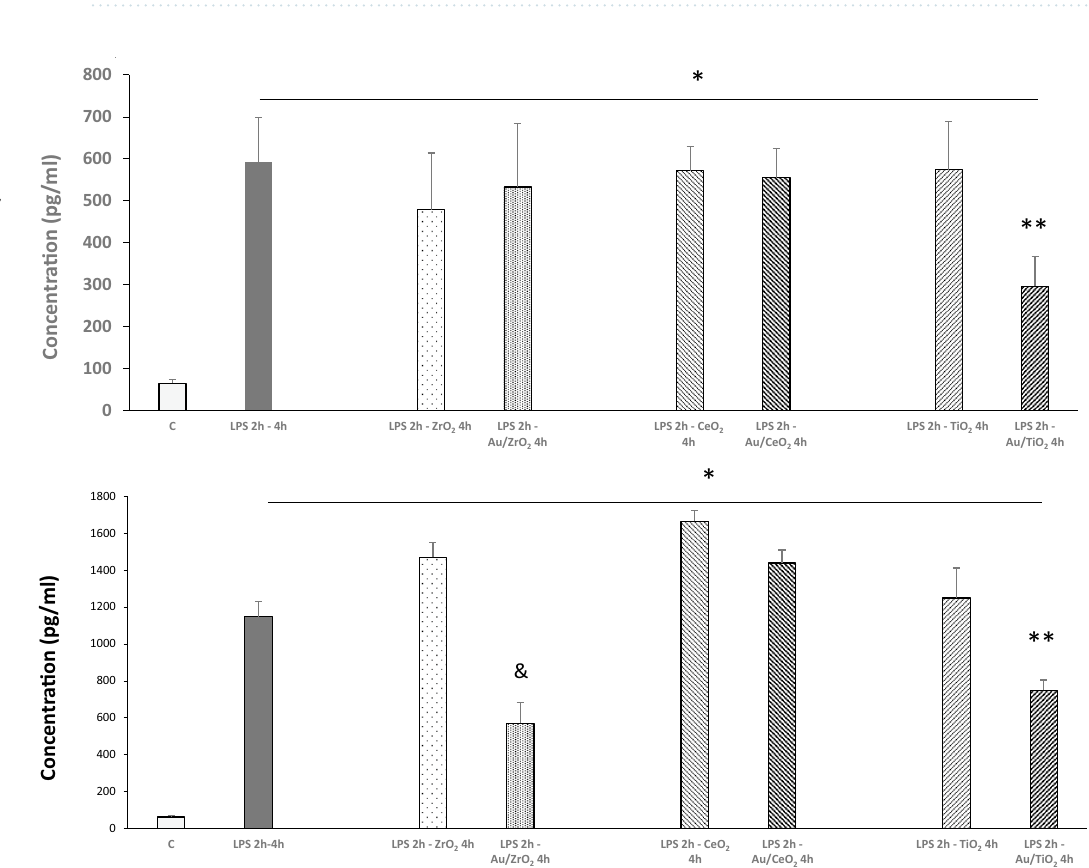
Figure 5. Effect of Au deposited on different metal oxide NPs on LPS induced TNF-α and IL-1β secretion by mouse peritoneal macrophages ( a , b ). Cells were incubated with culture media for 6 h (control condition, C) or LPS for 2 h, and then the following 4 h with LPS alone or LPS plus the different MOx or Au/MOx NPs (50 µg ml −1 ). *Significantly different from C ( p < 0.05), **significantly different from LPS 2 h—TiO 2 4 h ( p < 0.05 ), & significantly different from LPS 2 h—ZrO 2 4 h ( p <